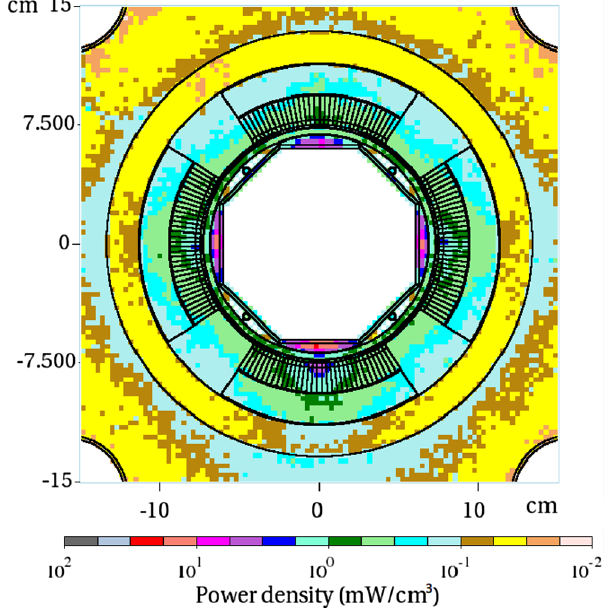
FIG. 7. Power density isocontours at the IP end of the Q2B quadrupole.